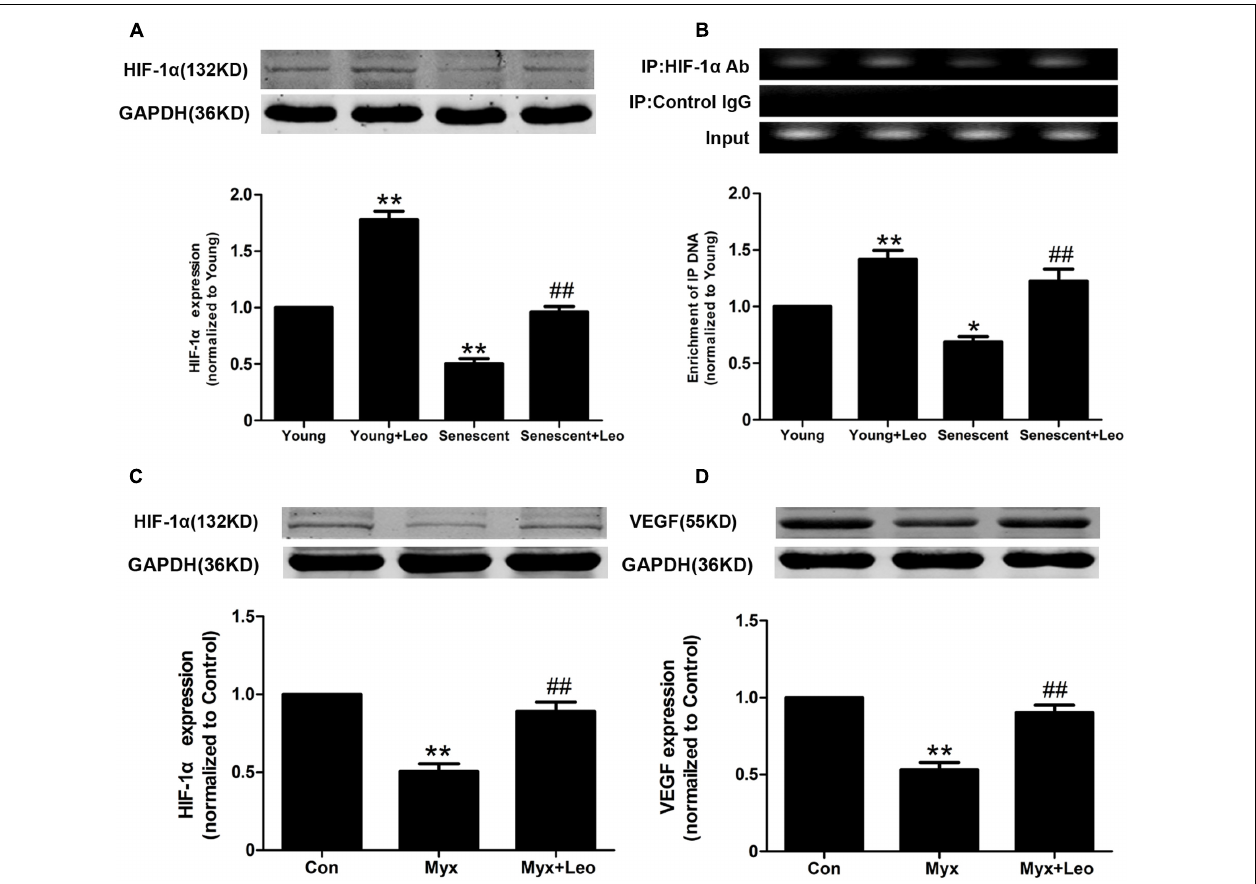
FIGURE 8 | Leonurine increases VEGF expression in senescent HUVECs via activation of HIF-1 α . (A) The effects of aging and leonurine on HIF-1 α expression in HUVECs detected by Western-blot. (B) The effects of aging and leonurine on the binding of HIF-1 α to VEGF gene promoters detected by chromatin immunoprecipitation (ChIP). (C,D) Leonuine restores the expresssions of HIF and VEGF compromised by myxothiazol, an inhibitor of mitochondrial complex III. ∗ p < 0.05 vs. young group; ∗∗ p < 0.01 vs. young group; ## p < 0.01 vs. senescent group. Data are mean ±